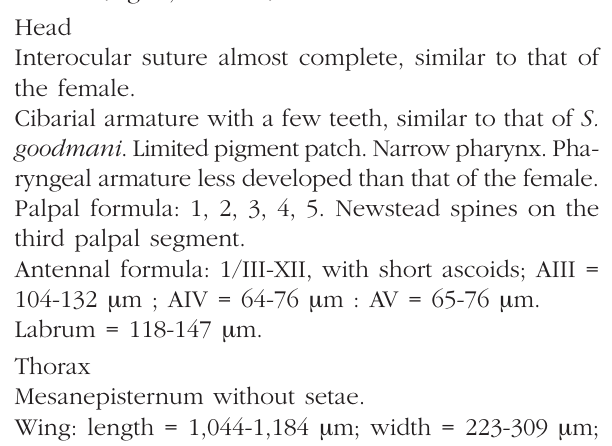
Head Interocular suture almost complete, similar to that of the female.